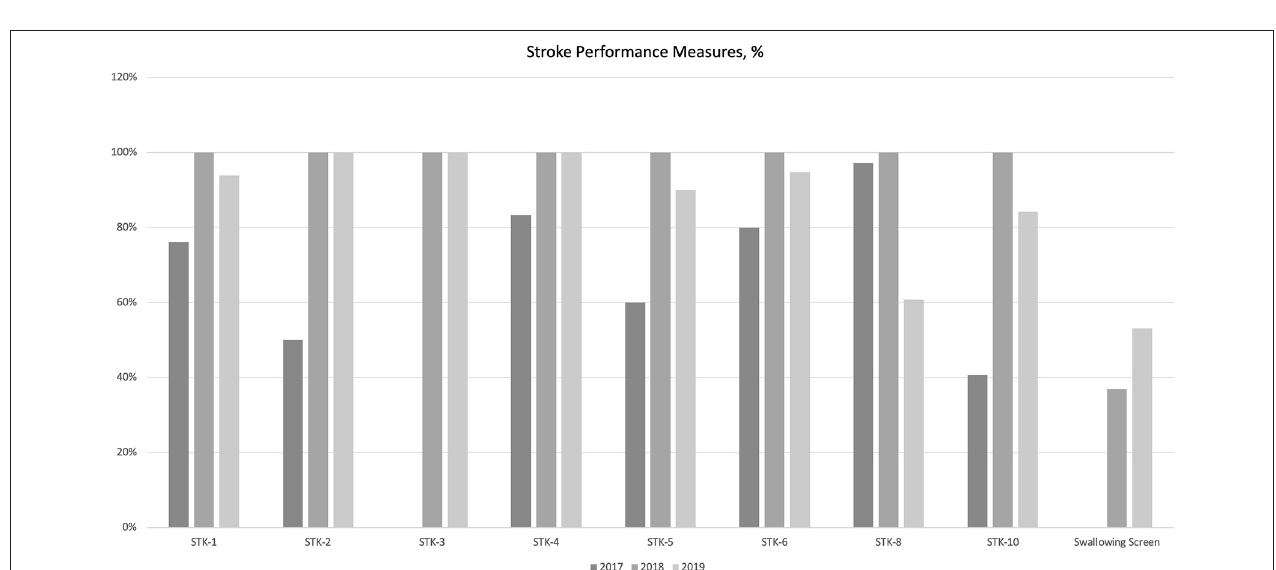
FIGURE 2 | Stroke performance meassures 2017–2019.